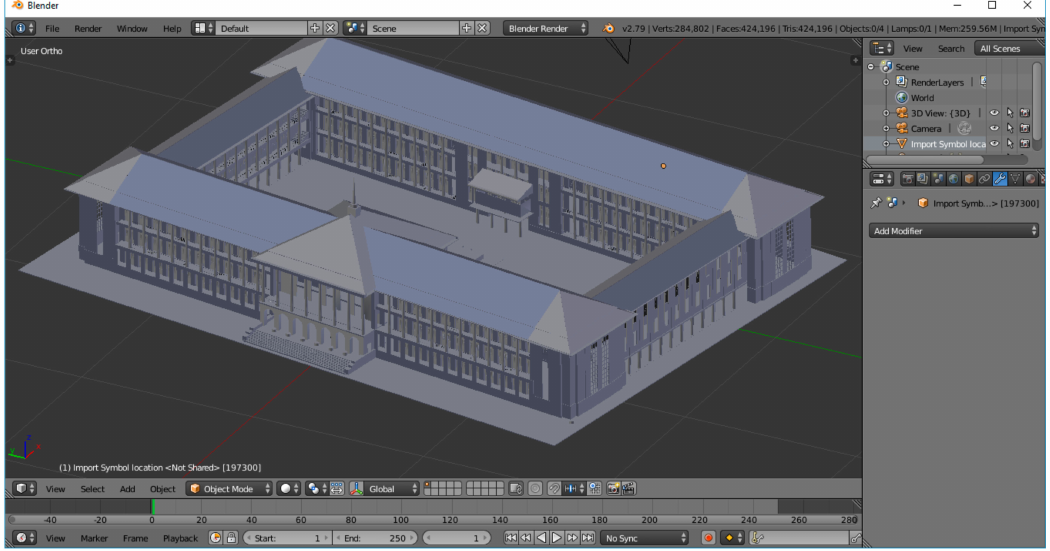
Figure 3. Blender for 3D model